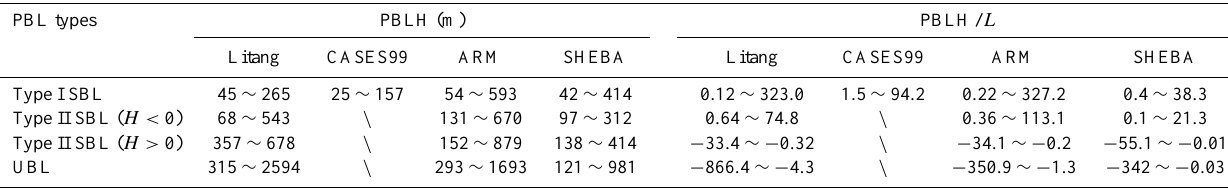
Table 1. The “observed” PBLH and the stability parameter at four observational sites. PBL